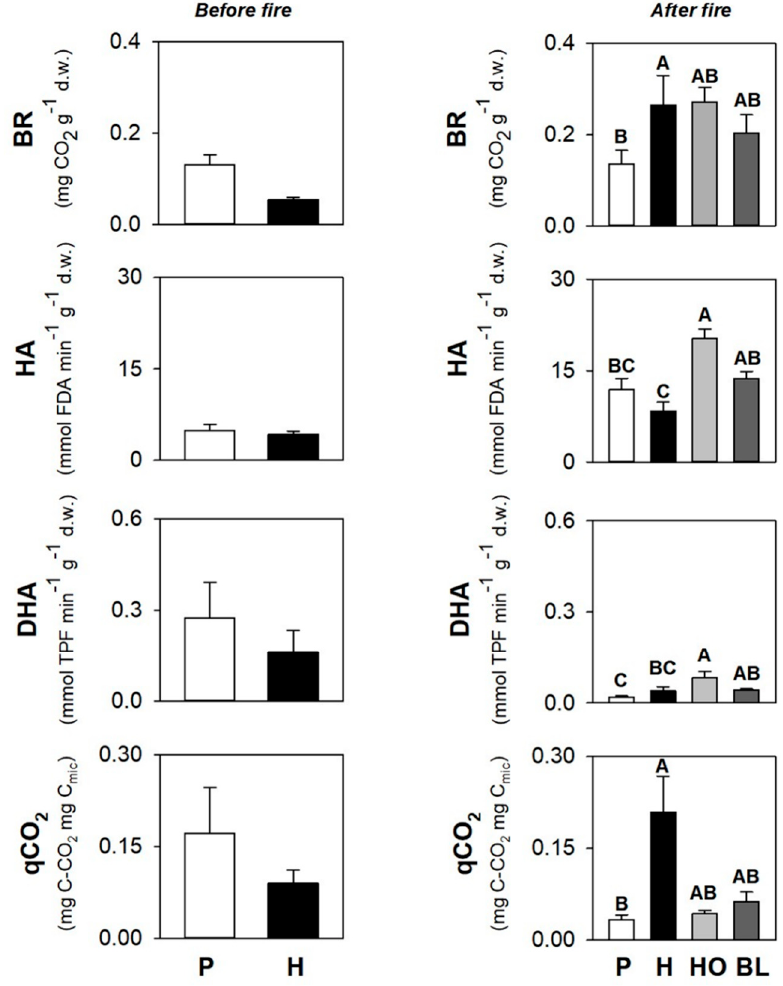
Figure 3. Mean values (±s.e.) of basal respiration (BR), hydrolase (HA) and dehydrogenase (DHA) activities, and metabolic quotient (qCO 2 ) of soil sampled under pine (P) and herbs (H) before the fire and under the pine (P), herbs (H), holm oak (HO), and black locust (BL) after the fire. Different uppercase letters indicate statistically significant differences ( p < 0.05) among different vegetation types in soils collected before and after the fire.